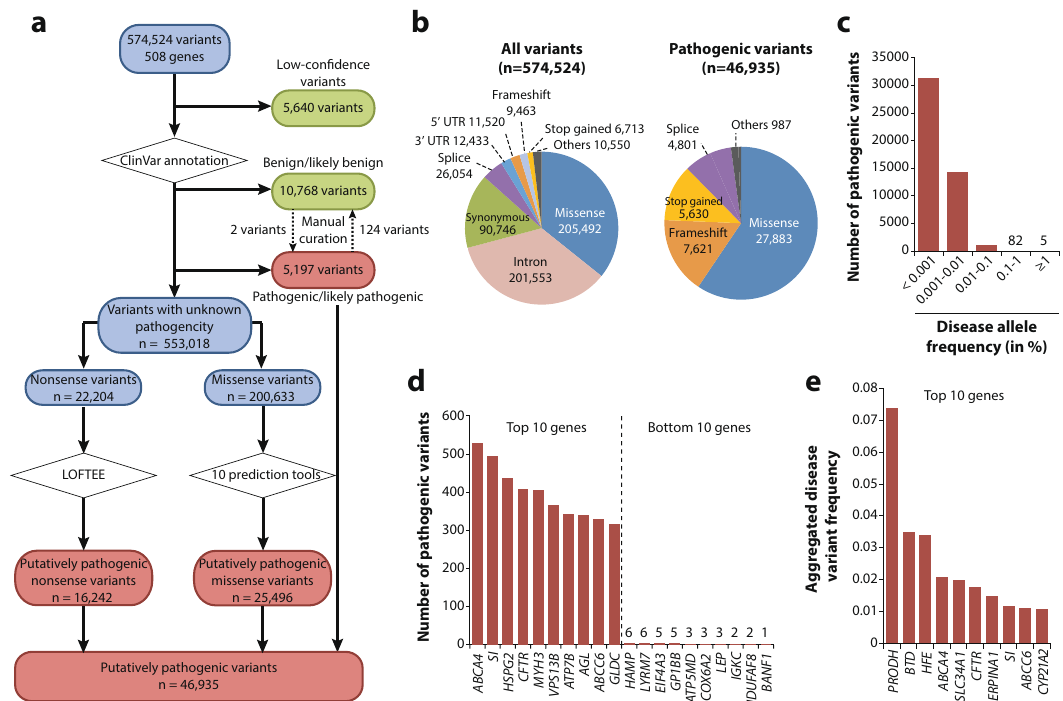
Fig. 1 The landscape of pathogenic variability differs drastically between genes. a Algorithm for pathogenic variant selection in human autosomal recessive disease genes. In total, 574,524 variants were identi fi ed in 508 genes associated with autosomal recessive disease. In a fi rst step, we removed low-con fi dence and benign variants, whereas all variants in these genes that were known to be pathogenic according to ClinVar ( n = 5197) were included for further analyses. Rare variants with unclear pathogenicity were analyzed computationally using LOFTEE for nonsense variants or ten computational prediction tools for missense variants (see “ Methods ” section for details). Variants that were deemed as pathogenic by LOFTEE ( n = 16,242) or all missense prediction algorithms ( n = 25,496) were combined with the variants with pathogenic ClinVar annotation to yield the fi nal data set of 46,935 pathogenic variants. b Pie charts visualizing the distribution of variant classes among all variants (left) and only among pathogenic variants identi fi ed in autosomal recessive disease genes (right). c The vast majority of pathogenic variants were very rare with global frequencies <0.001%, whereas only 82 and 5 pathogenic variants had frequencies between 0.1 – 1% and ≥ 1%, respectively. d Column plot showing the ten autosomal recessive disease associated genes with the highest and lowest number of pathogenic variants. Note that inter-gene differences in variant numbers exceed 500-fold. e The ten genes with the highest aggregated frequency of pathogenic variants are population-speci fi c carrier and newborn screening panels across seven populations. Furthermore, we calculated the genetic complexity of all 450 analyzed AR diseases and fi nd >25 diseases with pronounced population-speci fi c founder effects, most of which have not been previously described.